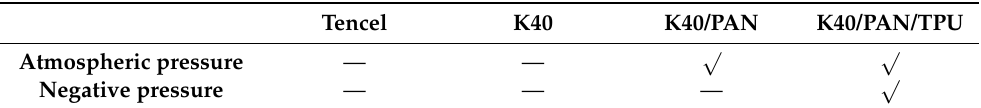
Table 3. Penetration of synthetic blood for Tencel, K40, and K40/PAN/TPU lay-up compound matrices at atmospheric pressure and negative